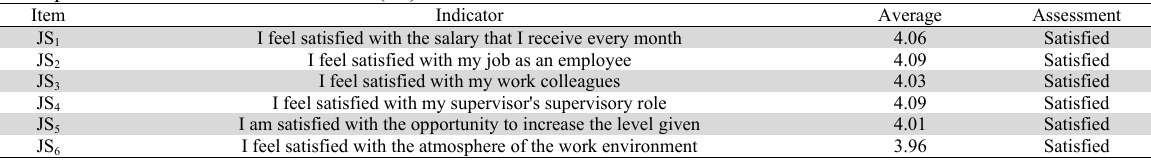
Description of Job Satisfaction Variable (X 1 )